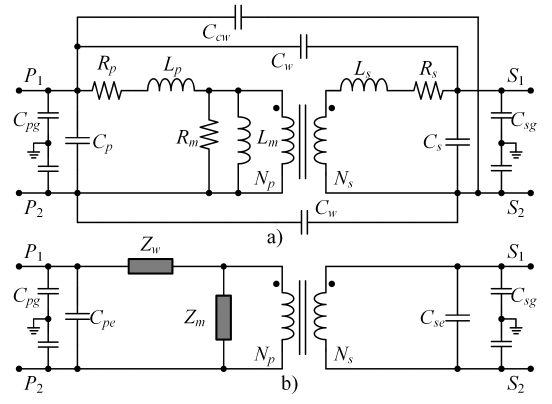
Figure 1. Medium-frequency transformer model: a) lumped parameters, and b) decoupled equivalent